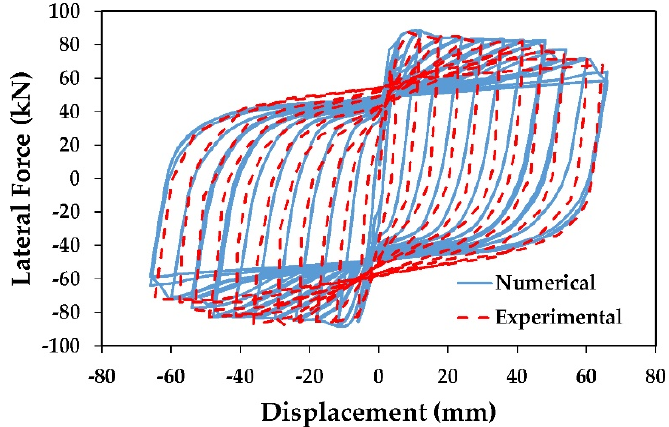
Figure 21. Comparison of the numerical and experimental hysteretic curve of the column C3-6-3 tested by Ding et al. [15] .